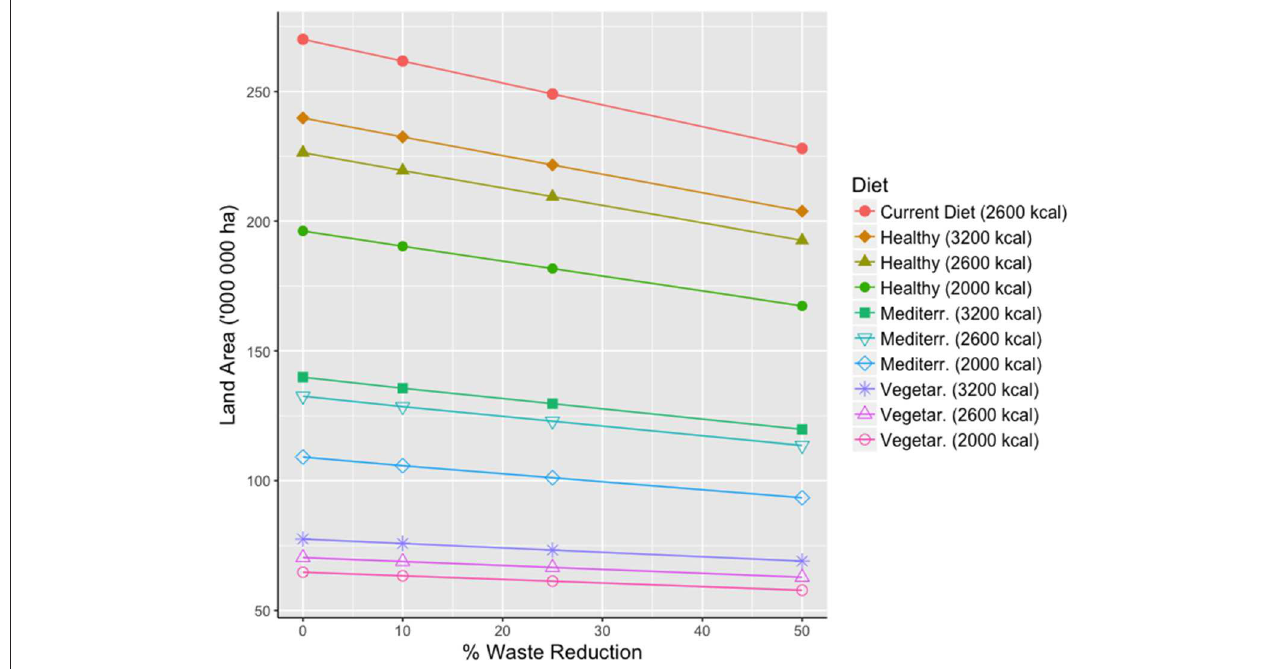
FIGURE 1 | Estimated land area required to meet dietary requirements of the US population following the current diet and 9 dietary scenarios with a 0, 10, 25, and 50% reduction in food waste along the retail-consumer chain.